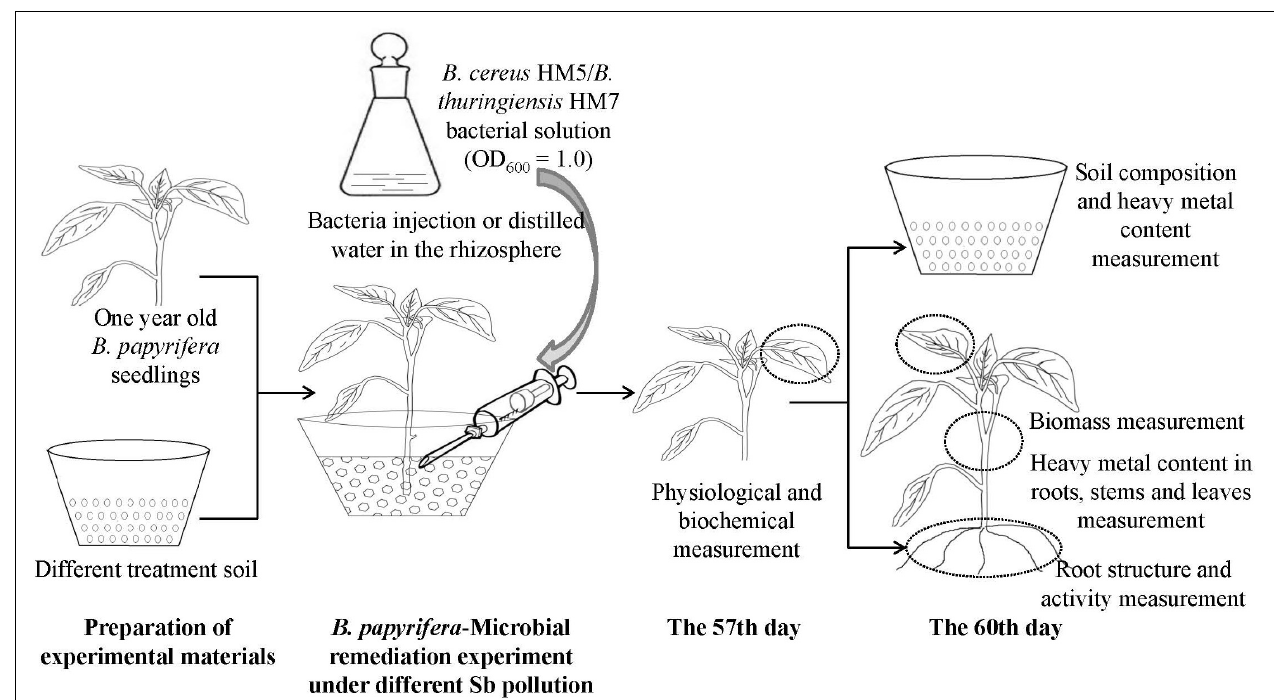
FIGURE 1 | Experimental process for the antimony